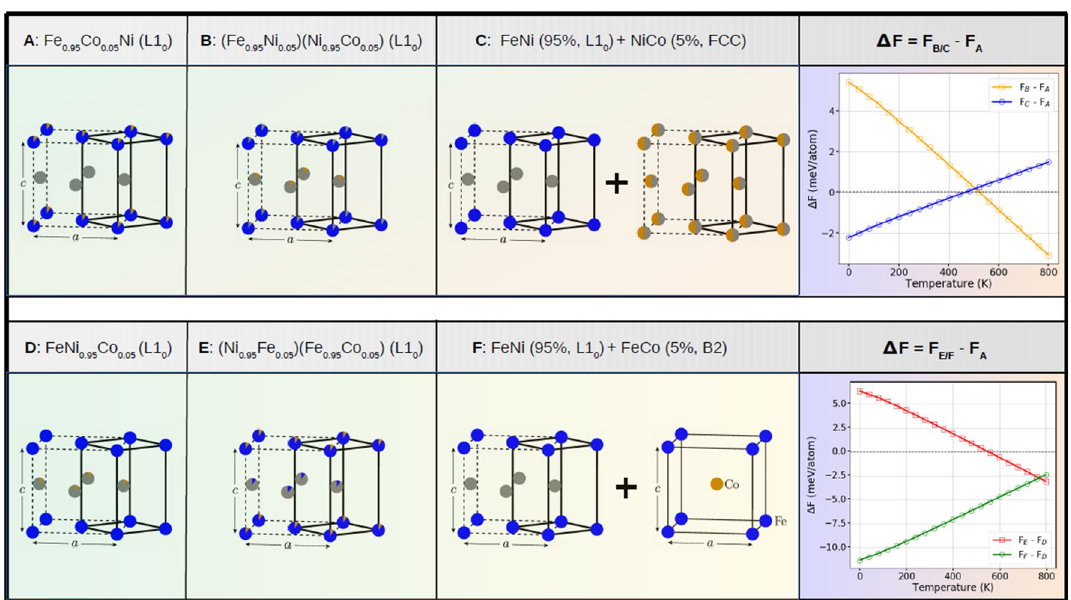
Figure 6. Different types of scenarios which would happen in experiments. Cases A , B and C represent doping on Fe site, and cases D , E and F represent doping on Ni site, respectively. The last column shows the free energy difference between cases B / C ( E / F ) and A ( D